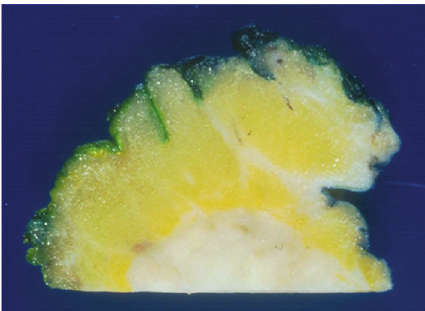
Figure 11: Close up of a perpendicular section of margins with tumor. The tumor is distant from the margin at the top of the image, but very close to a margin at the bottom right of the